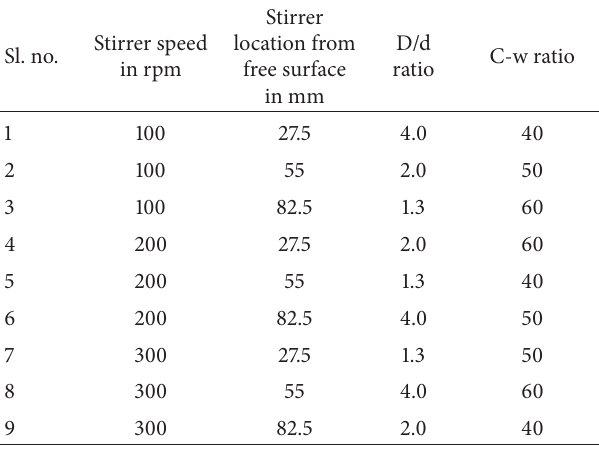
Table 5: Experimental layout using an 𝐿 9 (3 4 ) orthogonal array.